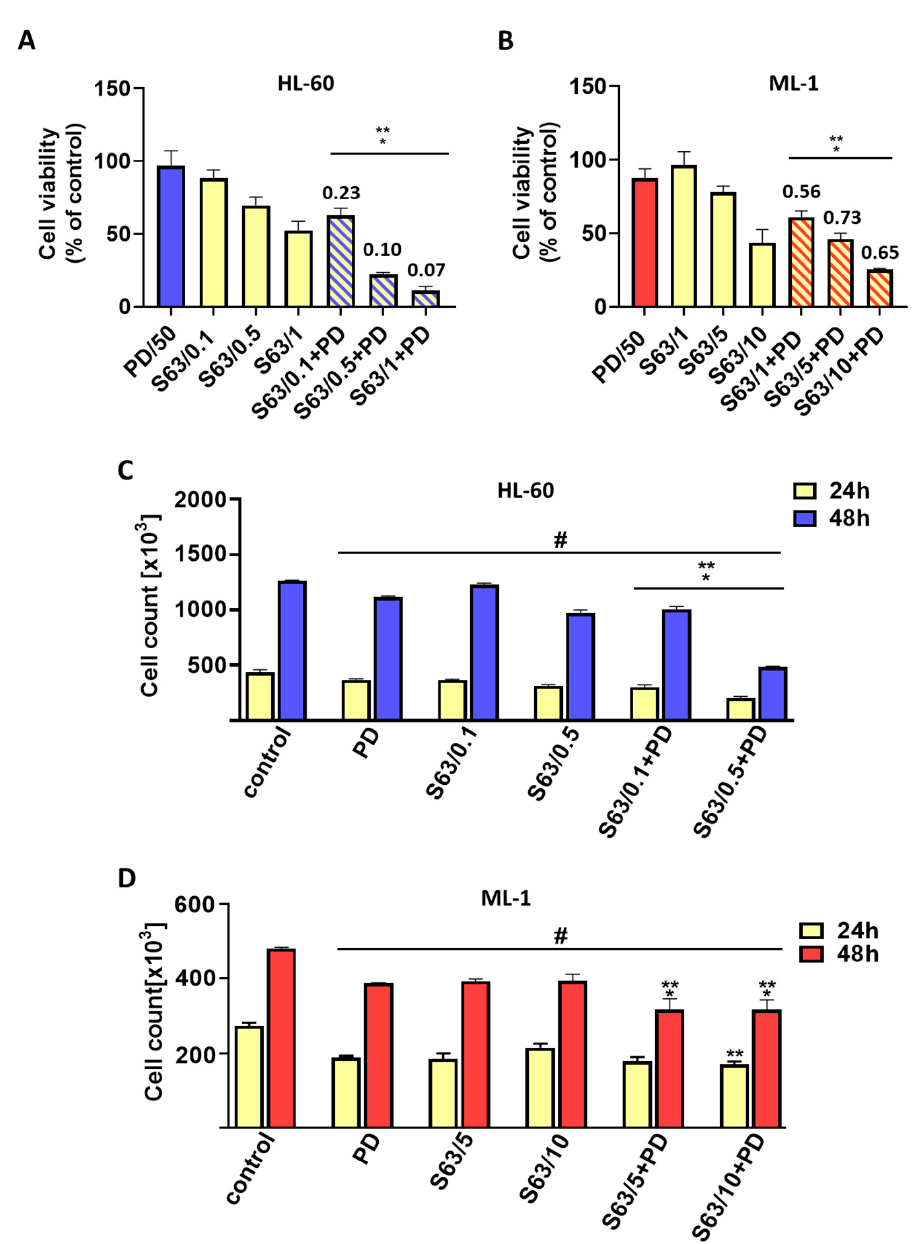
Figure 7. Effects of S63845 (S63) and MAPK inhibitor PD98059 (PD) given as single agent or in combination on the viability and count of AML cells. Using PrestoBlue assay, the cell viability of HL-60 ( A ) and ML-1 ( B ) cells was determined at 48 h. The synergism between the tested agents was determined by the combination index (CI) analysis at a non-constant ratio. The CI values, generated using the CompuSyn software according to the Chou–Talalay method, are given in graph ( A , B ). Using the Coulter method, the HL-60 ( C ) and ML-1 ( D ) cell count analyses were performed at 24 h and 48 h after application of the tested agents. Designations 0.1, 0.5, 5 and 10 indicate the S63845 concentrations ( µ M). Three independent experiments were performed in triplicate ( A , B ) or duplicate ( C , D ). Values are reported as the means ± SD. Values significantly different ( p < 0.05) according to one-way ANOVA are designated by * and ** compared to, respectively, S63845 or PD98059—single treated group; # compared to the corresponding control.